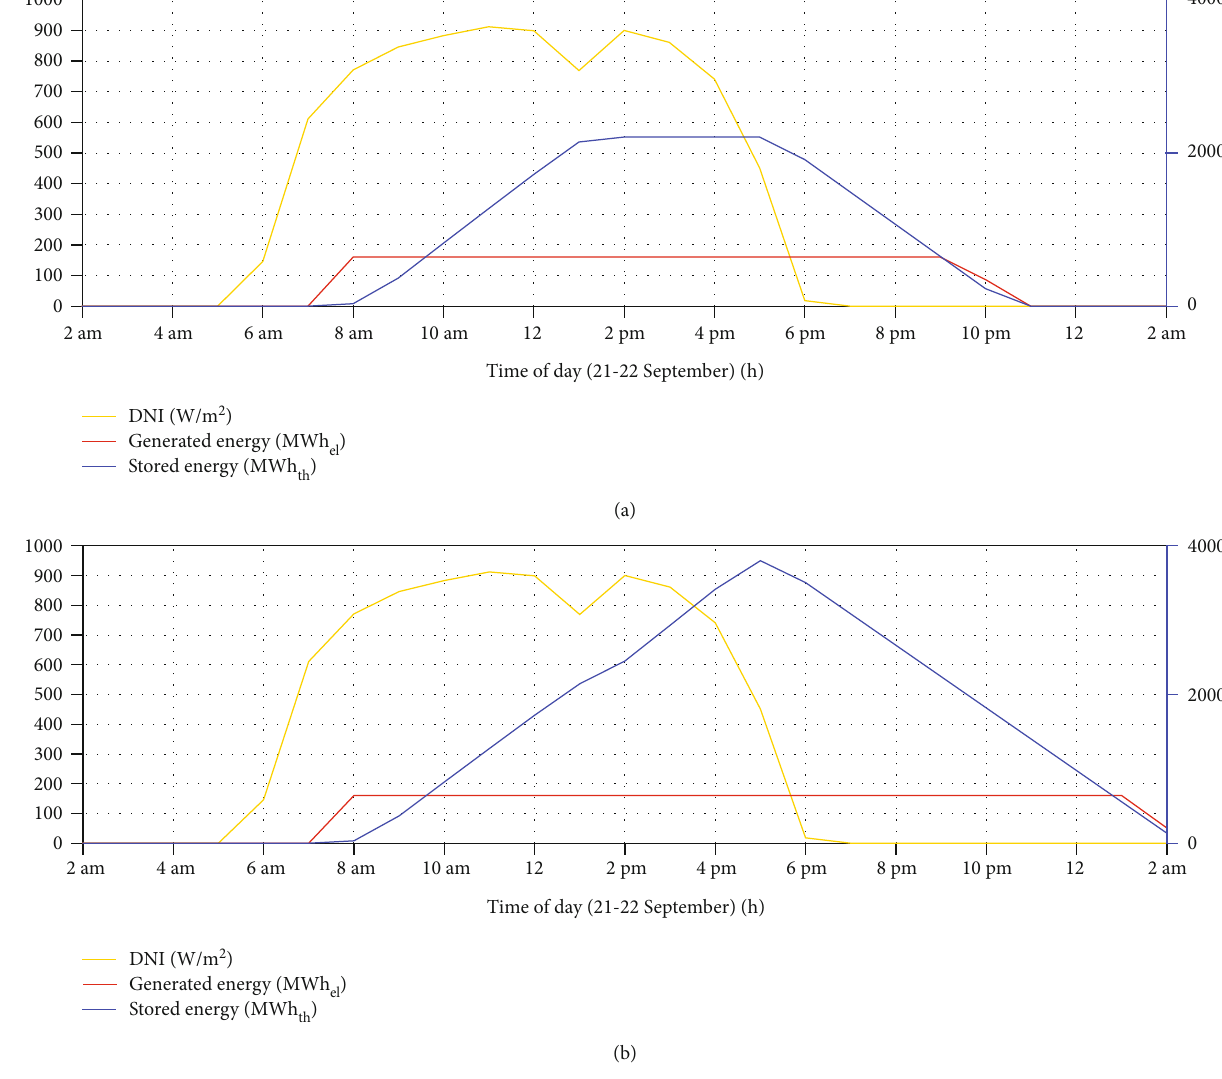
Figure 5: The in fl uence of storage capacity on the system energy generated: (a) TES = 6 h , (b) TES = 12h (CSP plant with 150MW and SM = 3